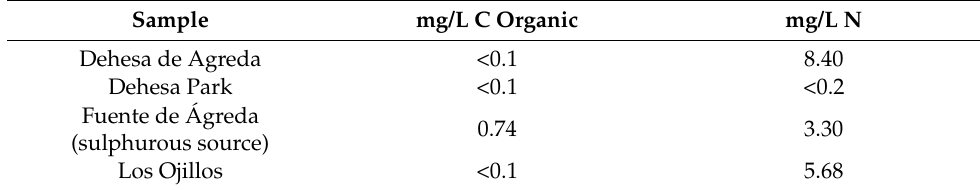
Table 3. Analysis of organic matter and nitrogen compounds in the waters of the Á greda area.